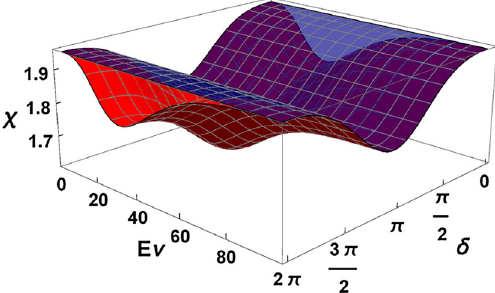
Fig. 3 Coherence parameter χ as defined in Eq. (7), for the state in Eq. (13), is plotted with respect to the CP violating phase δ and the energy E ν of the neutrino. The blue and red surfaces correspond to the cases with and without decoherence parameter, respectively. The minimum of the coherence parameter occurs for E ν ≈ 30 MeV and δ =